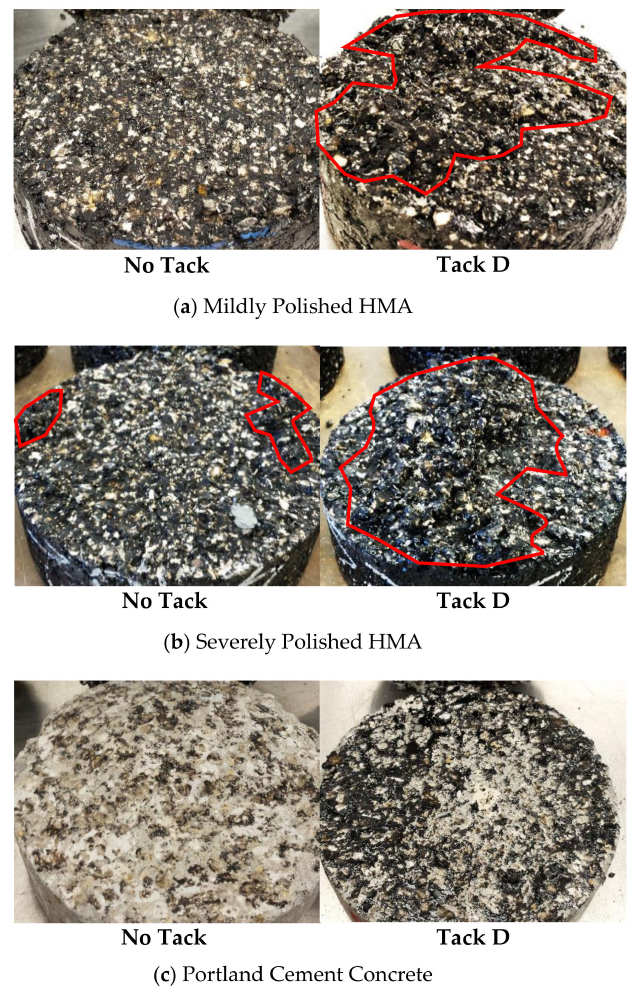
Figure 8. Shear failure of laboratory compacted samples applied without tack and with Tack D on different surfaces: ( a ) mildly polished HMA, ( b ) severely polished HMA, and ( c ) Portland cement concrete. Note: red marked areas indicate the failure through the overlay mixture.